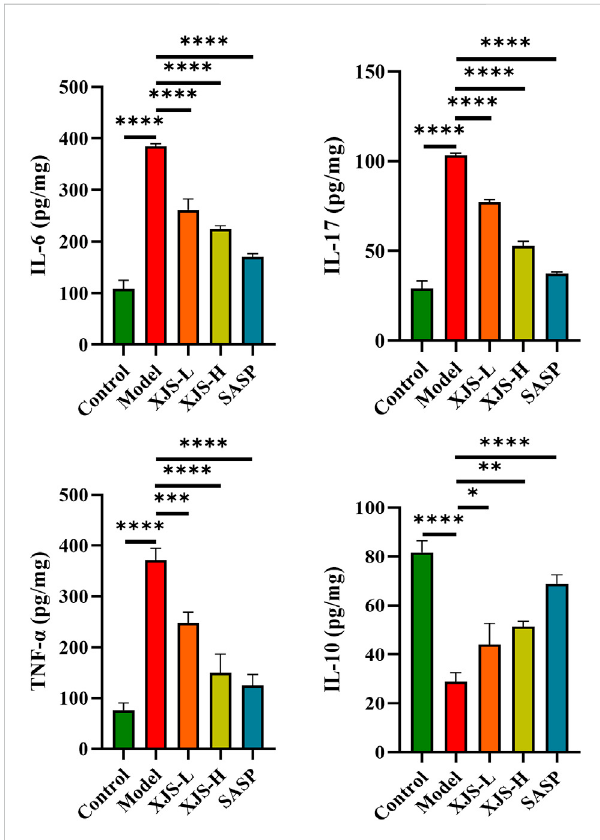
FIGURE 3 Theexpressionlevelsofin fl ammatorycytokinesIL-6,IL-17,TNF- α , and IL-10 in the colon tissues ( n = 3). * p < 0.05, ** p < 0.01, *** p < 0.001, **** p <